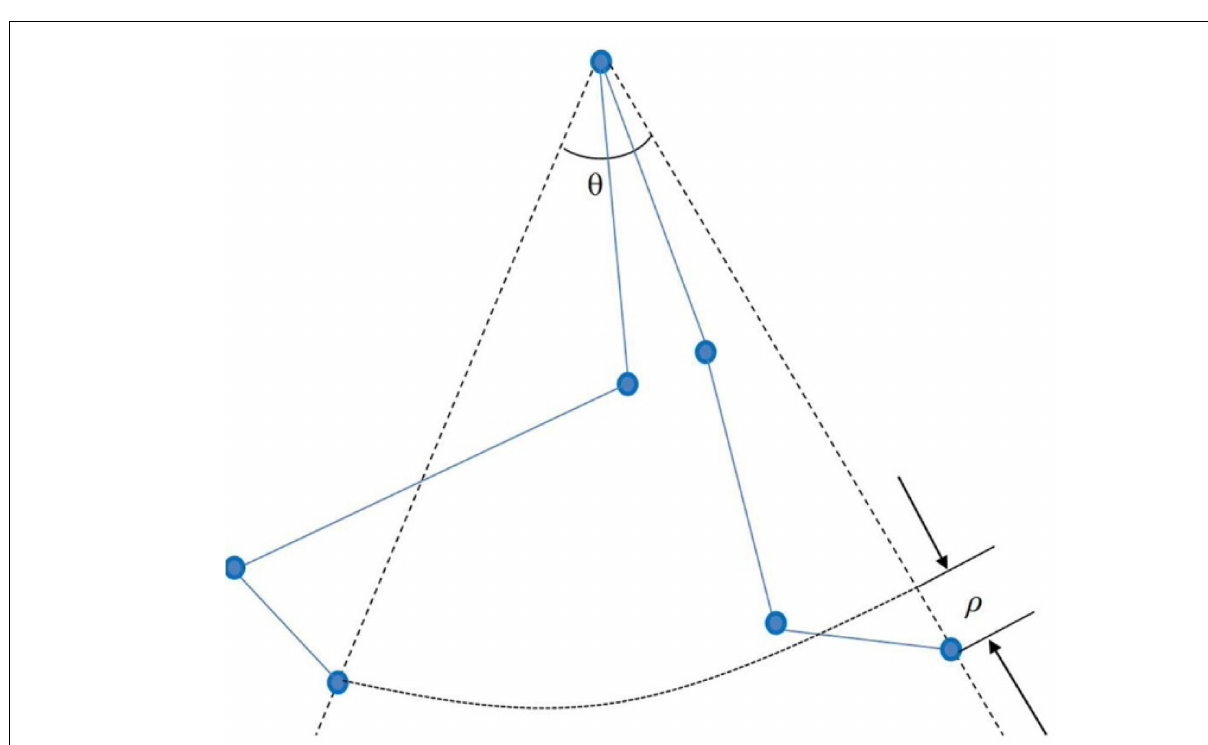
FIGURE 3 | Processing gait data in VICON.